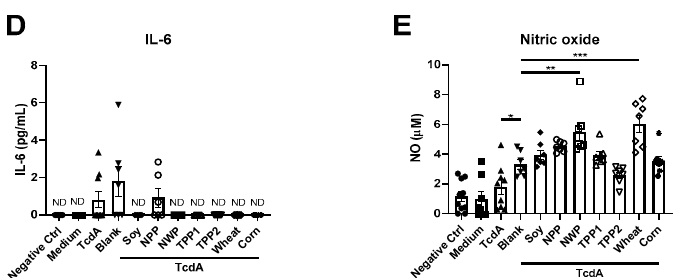
Figure 2. Potency of plant-based dietary protein to restore the e ff ect of Clostridium di ffi cile-secreted